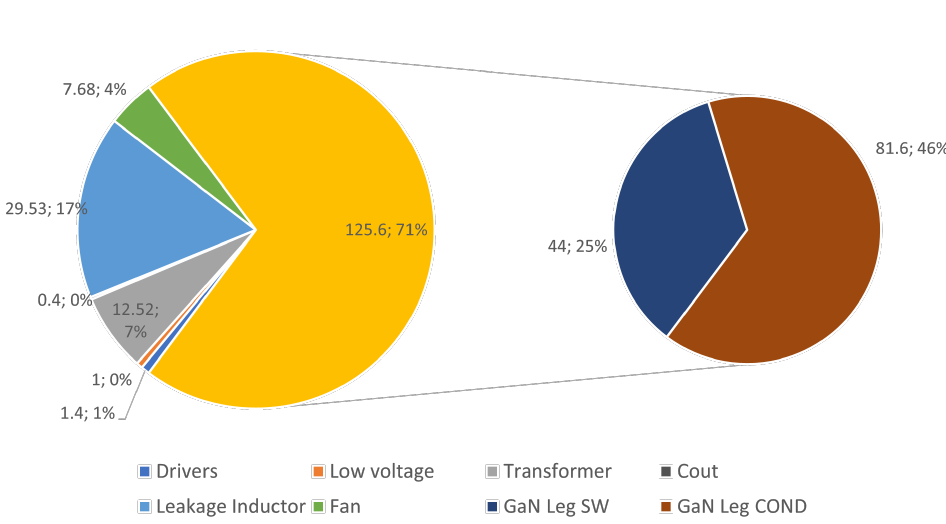
Figure 11. Distribution of power losses in the overall system at P out = 7.5 kW; point